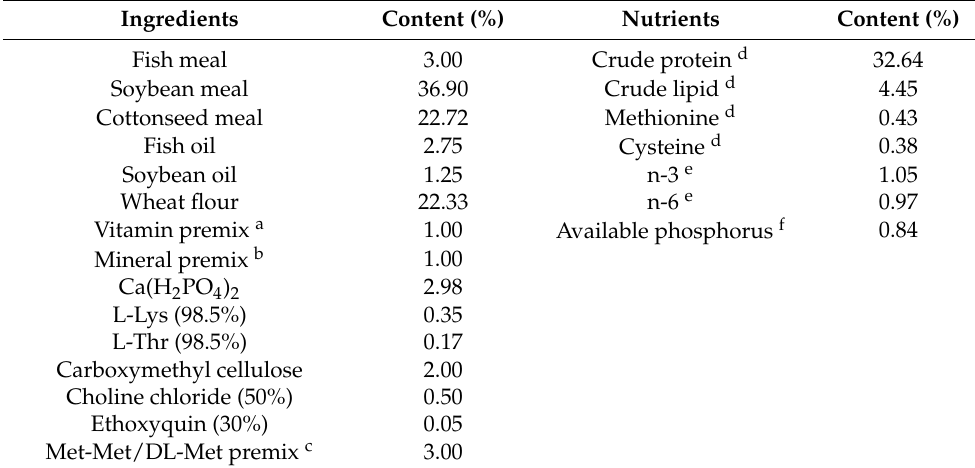
Table 1. Formulation and nutrients content of the basal